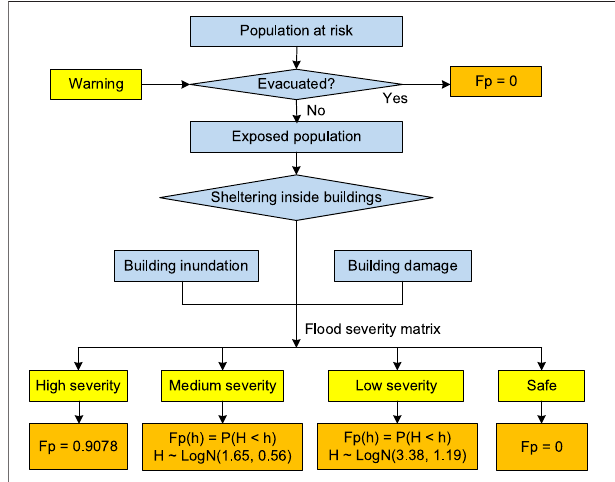
FIGURE 3 | The framework of the human risk assessment model for a landslide dam (modi fi ed from Peng and Zhang, 2012b; Peng and Zhang, 2013a).